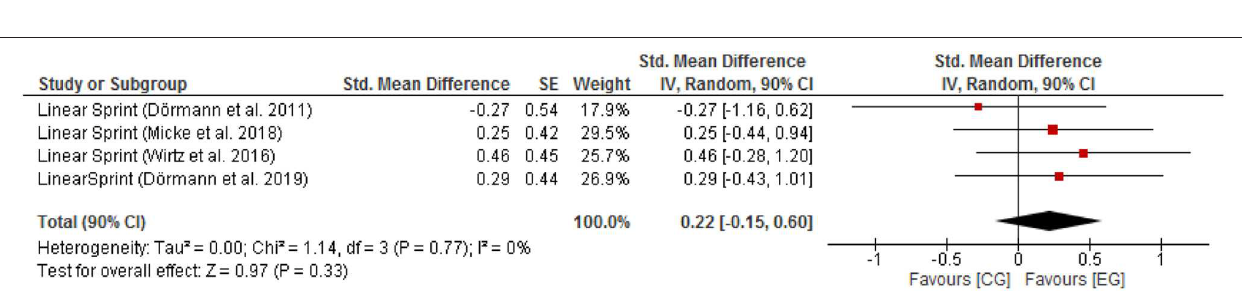
FIGURE 2 | Pmax for CG vs. EG. SE, standard error; CI, confidence interval; Std., standardized; IV, independent variable.